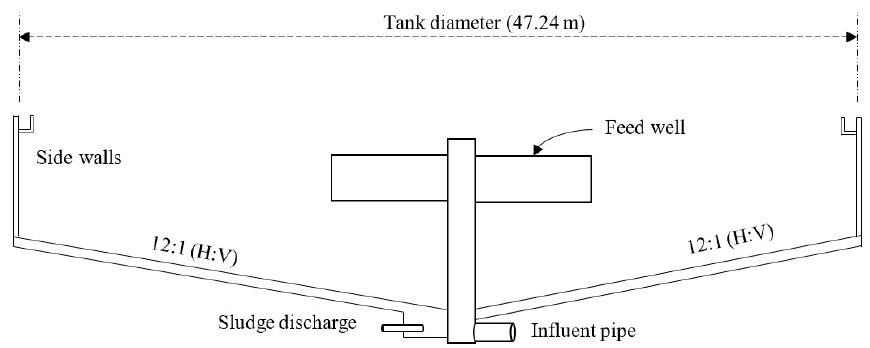
Figure 1. Schematic view of Chicago tank – adapted from Liu and Garcia (2010).